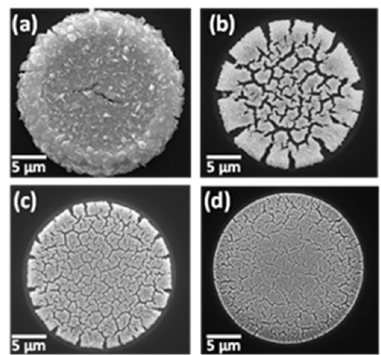
Figure 9. LSV at NPG-modified gold microdisc array electrodes at 10 mV s − 1 in Ventolin TM solutions (pH 4) containing 2 mg/mL salbutamol (as sulphate) in 0.0154 M NaCl and 0.05 mM H 2 SO 4 following